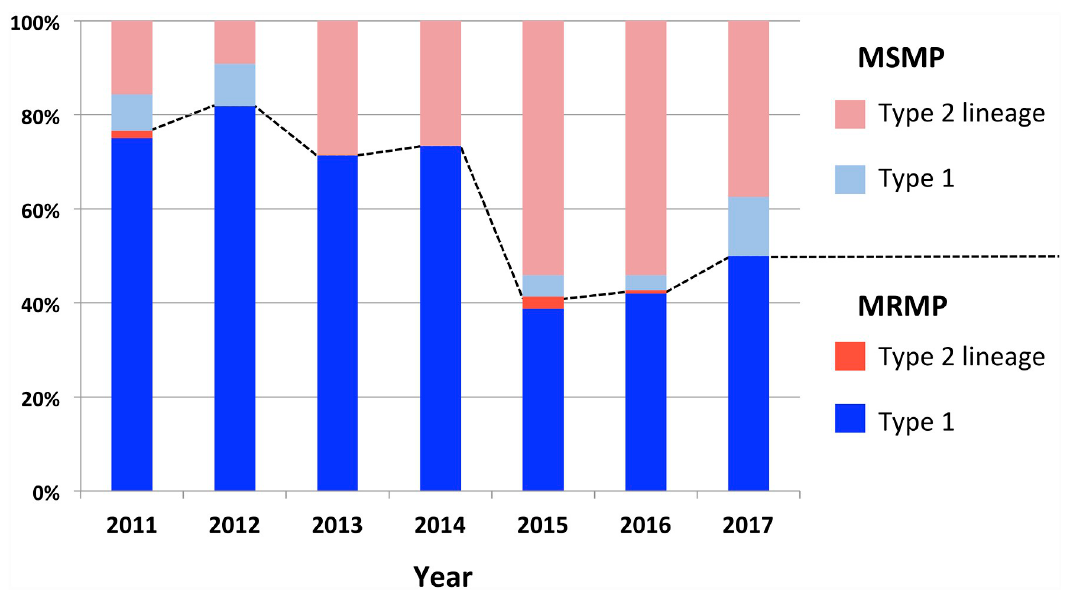
Fig 4. Annual rates of isolation of macrolide-resistant M . pneumoniae (MRMP) and macrolide-susceptible M . pneumoniae (MSMP) strains in Osaka in 2011–2017. The fractions of p1 gene type 1 and type 2 lineage MRMP isolates are shown in blue and red, respectively. The fractions of p1 gene type 1 and type 2 lineage MSMP isolates are shown in light blue and pink, respectively. Dotted line indicates the boundary between MRMP and MSMP strains. Also see S4